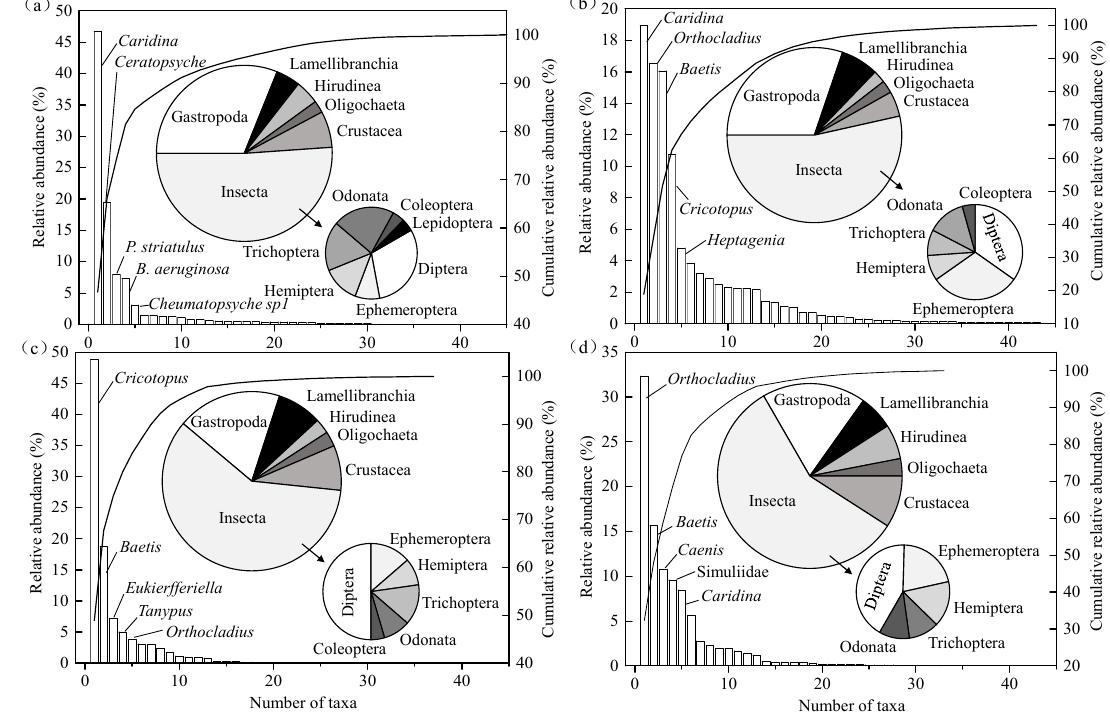
Figure 4. Macroinvertebrate communities of the Huai River basin sampled on summer ( a ), autumn ( b ), winter ( c ), and spring ( d ) in the year 2014–2015. Vertical bars represent relative abundances of each taxon from all sites in the study region, with the five most abundant taxa labeled. Solid lines depict the asymptotic nature of cumulative relative abundance in these communities (right-hand axis). Pie graphs show the composition of macroinvertebrates among classes based on the number of taxa. The small pie graphs show the detailed composition of Insecta among orders.